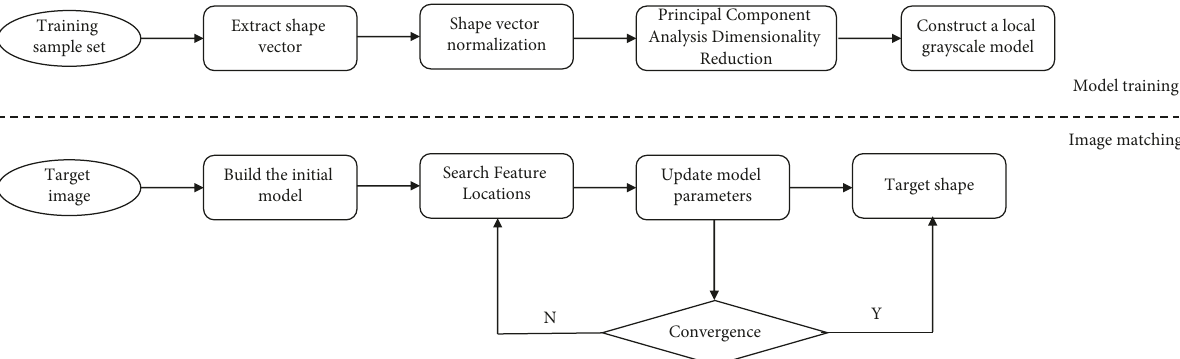
Figure 3: Calculation flow of the active shape